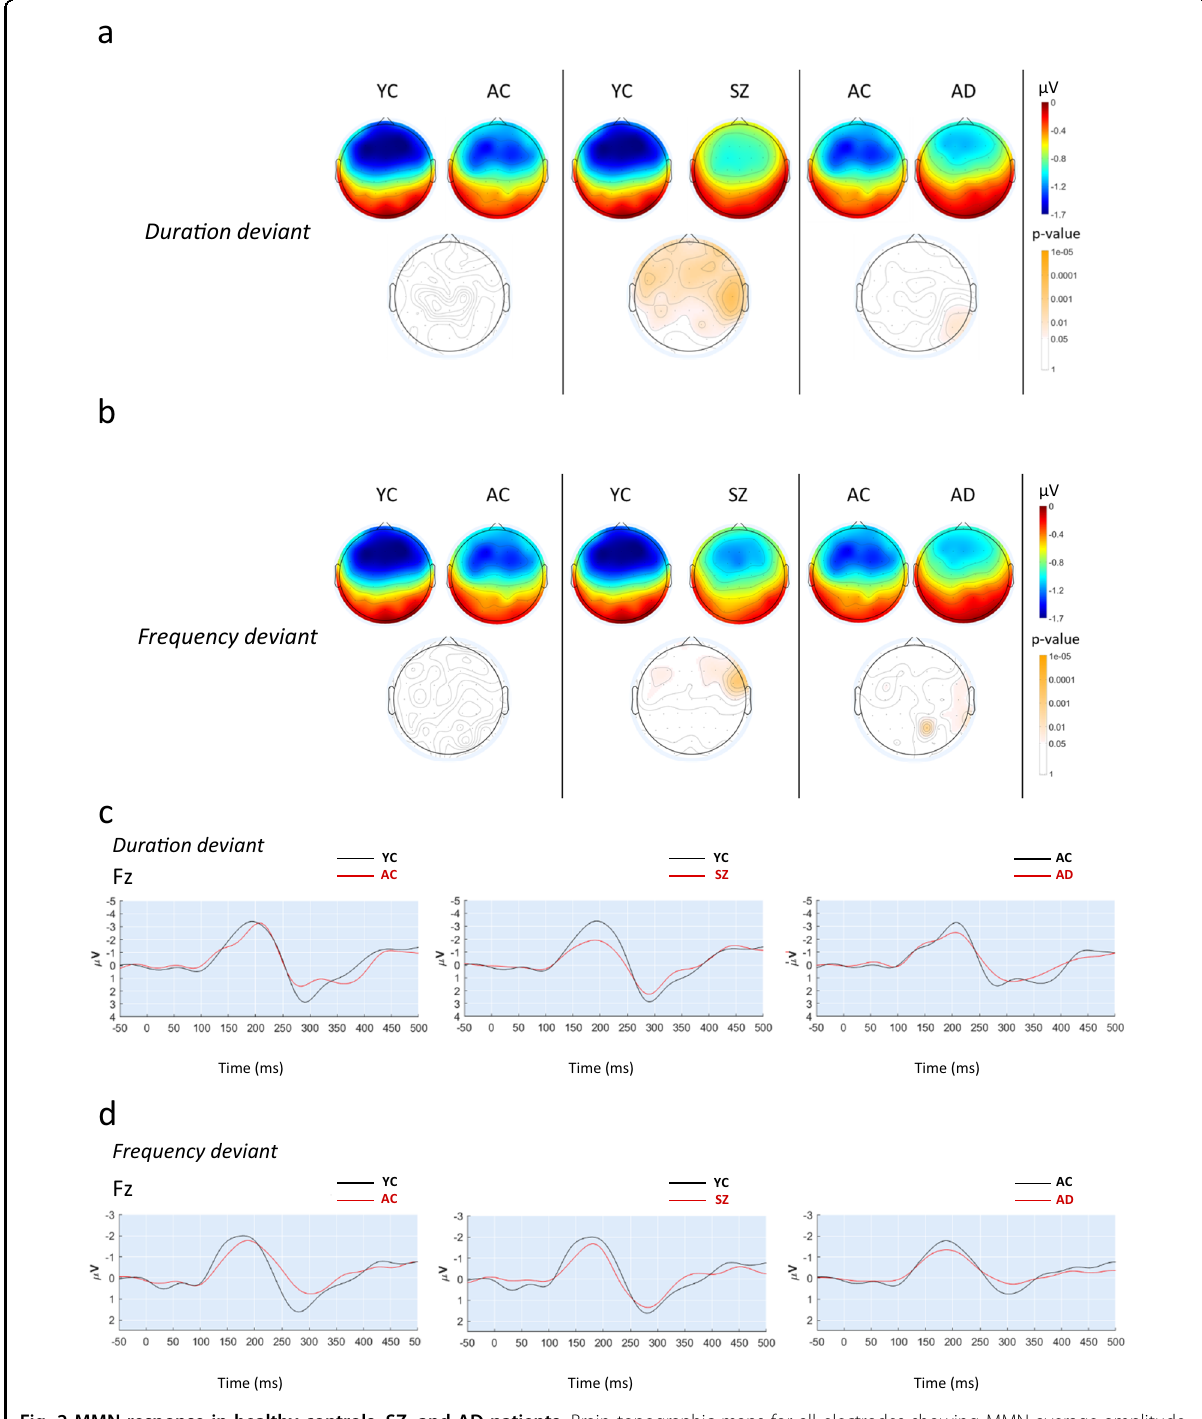
Fig. 2 MMN response in healthy controls, SZ, and AD patients. Brain topographic maps for all electrodes showing MMN average amplitude during the auditory oddball paradigm (50-ms standard tones of 1000 kHz, 100-ms duration-deviant tones of 1000 kHz, and 50-ms frequency-deviant tones of 1050 Hz) in young controls (YC), aged controls (AC), Schizophrenia patients (SZ), and Alzheimer ’ s disease patients (AD) for duration deviants ( a ) and frequency deviants ( b ). Below each pannel, the corresponding p-values are shown as brain heatmaps and obtained for the indicated comparisons using a two-sample two-tail Student ’ s t test. The results are expressed as means. ( c ) Grand average-evoked potentials elicited during the auditory oddball stimulation and illustrating MMN average amplitude at the Fz electrode for duration and frequency deviants ( d ) in young control (YC), aged control (AC), schizophrenic patients (SZ), and Alzheimer ’ s patients (AD). The results are expressed as mean and negativity is plotted as an upward de fl